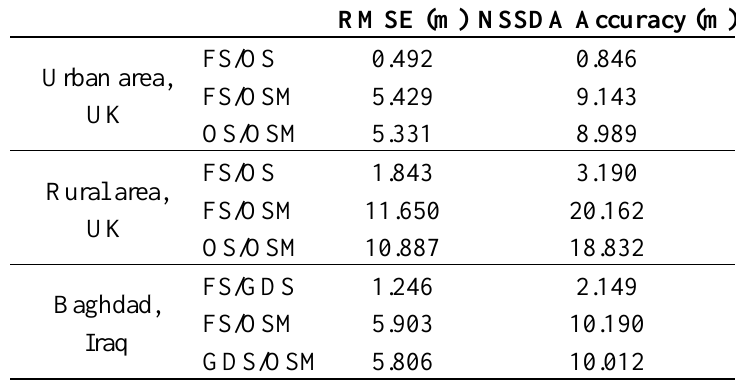
Table 1. Comparisons of Root Mean Standard Error (RMSE) and National Standard for Spatial Data Accuracy (NSSDA) positional discrepancies for compared